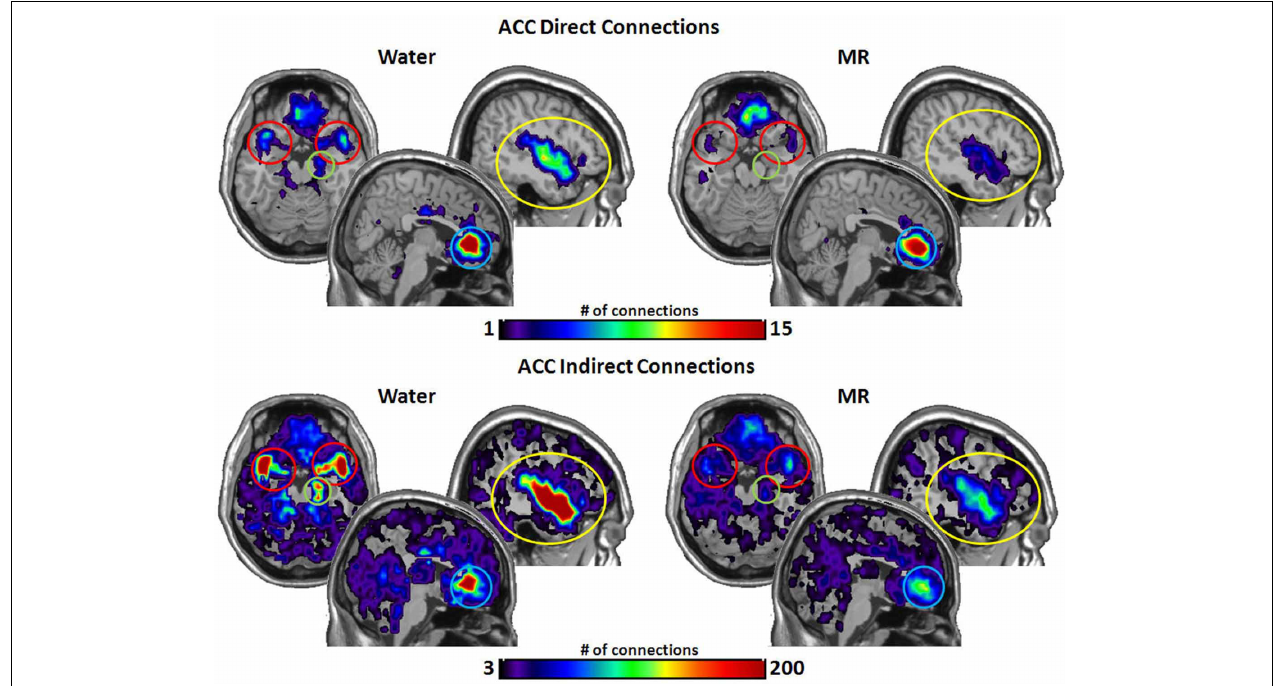
FIGURE 5 | The brain images on the top demonstrate the total number of direct connections from the anterior cingulated cortex (ACC) averaged across participants. These images demonstrate that the ACC has a greater number of direct connections to the insula during the water than in the MR condition. It appears that the ACC also has greater direct connections with the STP in the water